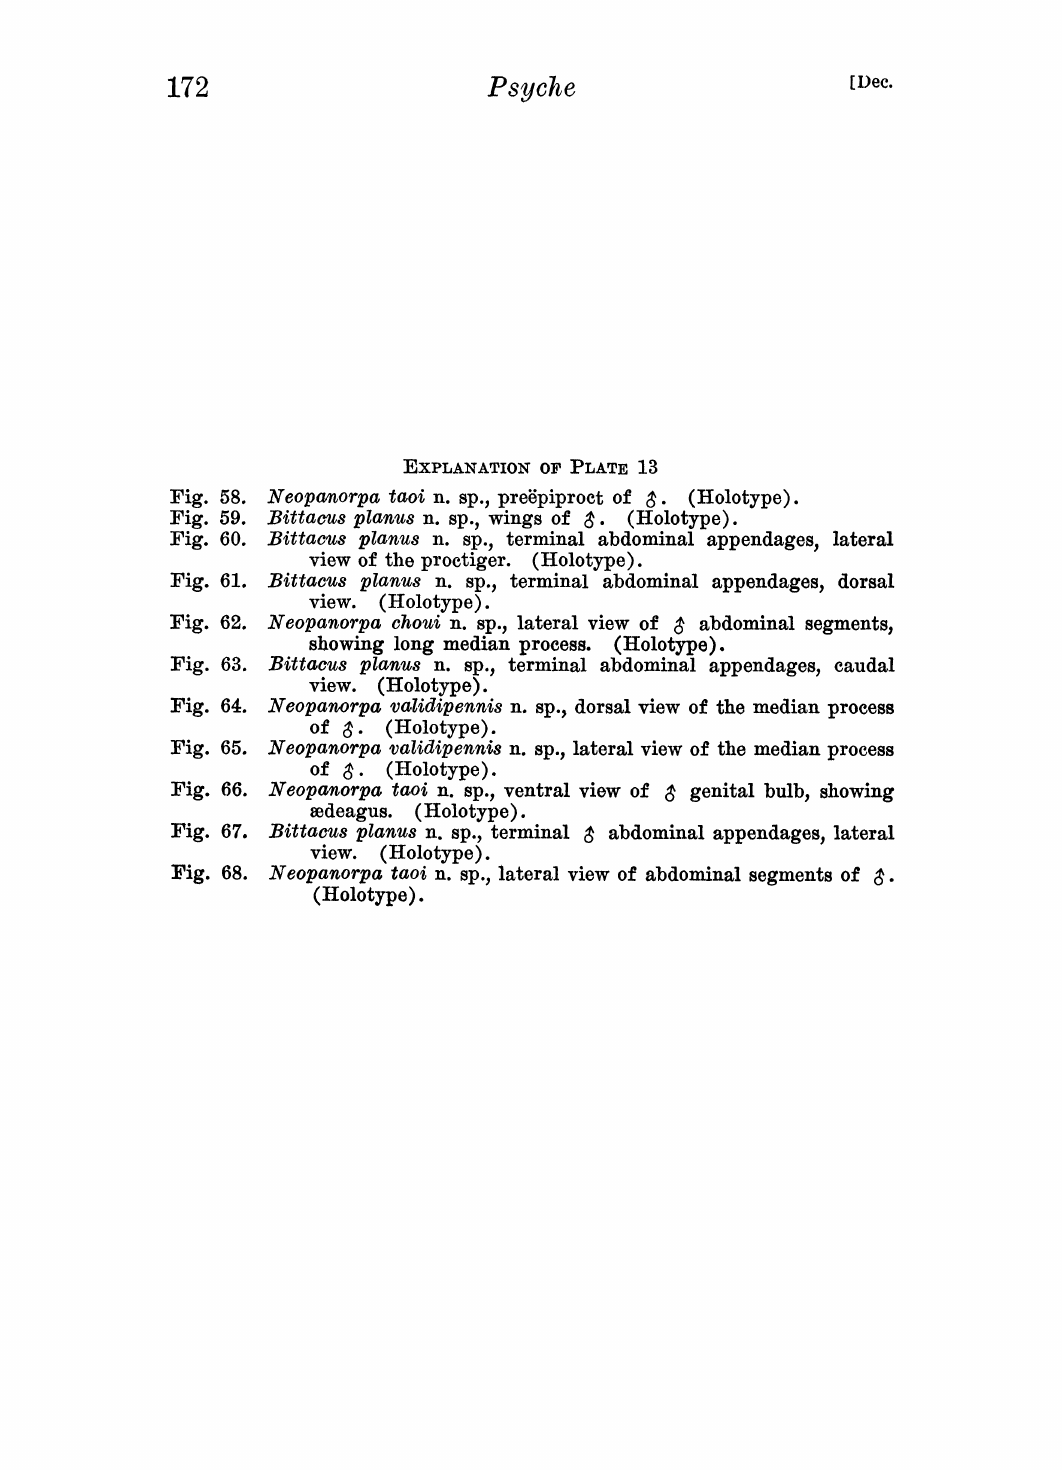
Fig. Fig. Fig. Fig. Fig.